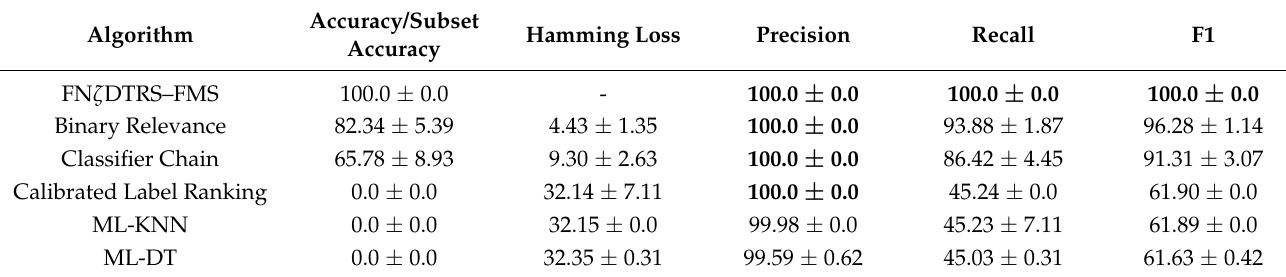
Table 11. The results of the simultaneous-fault